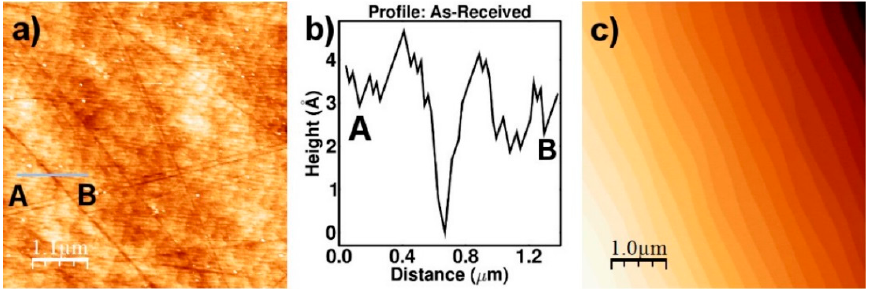
Figure 43. AFM image of an ( a ) as-received SiC(0001) substrate; ( b ) a line-profile from A to B; ( c ) hydrogen-etched SiC [156].